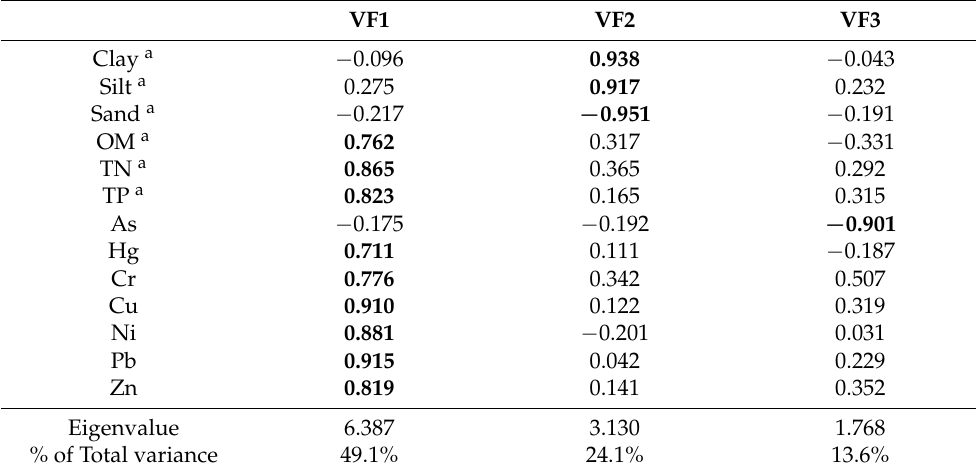
Table 4. Corresponding variable loadings, eigenvalues, and explained variance obtained from PCA/FA for the entire data set. VF1 VF2 VF3 Clay a − 0.096 0.938 − 0.043 Silt a 0.275 0.917 0.232 Sand a − 0.217 − 0.951 − 0.191 OM a 0.762 0.317 −